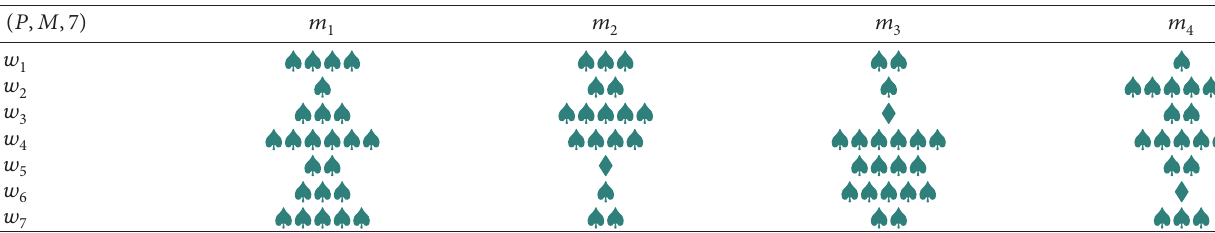
Figure 2: Specification of investigated Table 18: Rating of spacecraft.